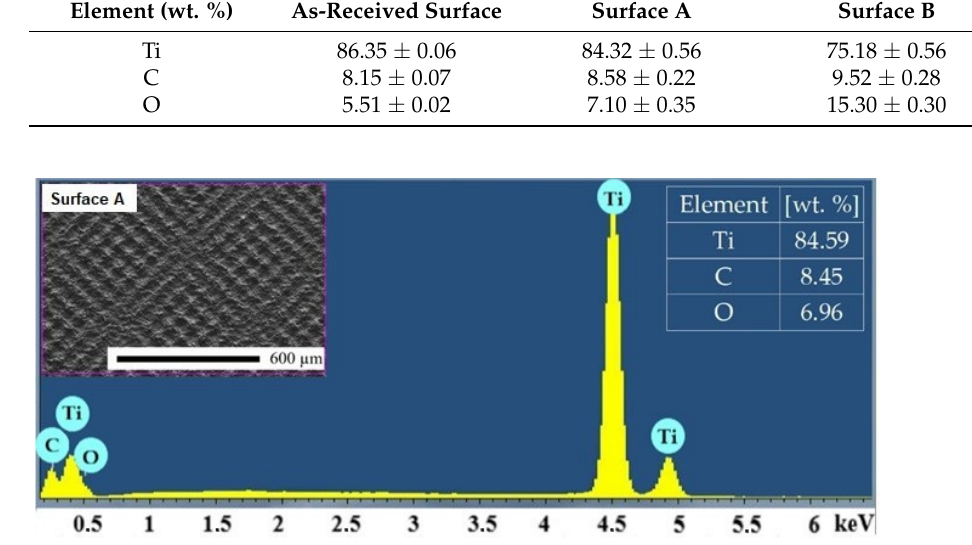
Figure 4. Representative EDS spectrum of Surface A.